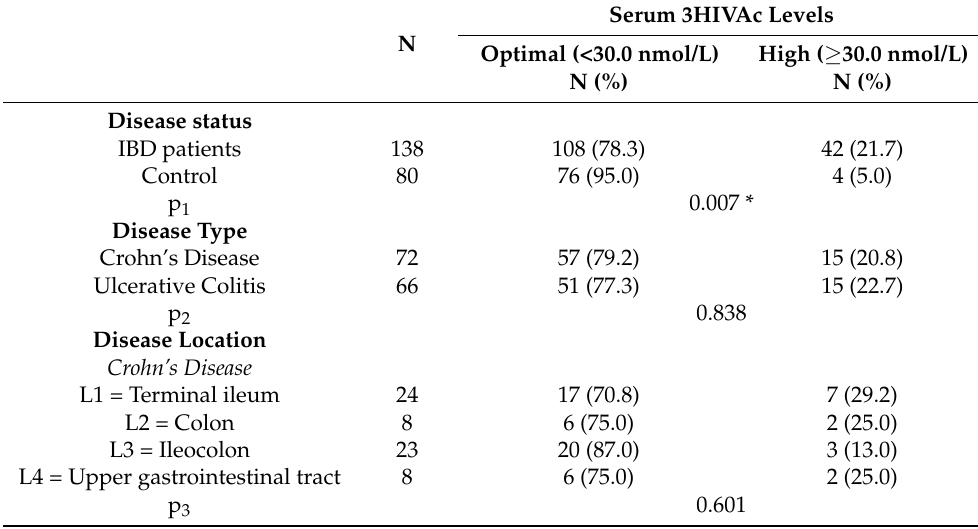
Table 3. Frequency of biotin deficiency in patients with IBD in comparison to controls.